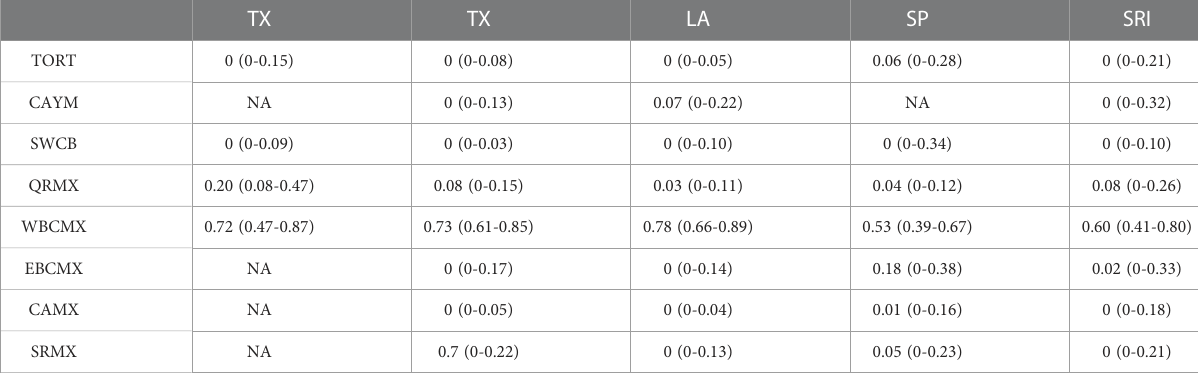
TABLE 3 Median contribution estimates to Gulf of Mexico green turtle foraging aggregations from Bayesian many-to-one mixed stock analysis assuming uniform priors.